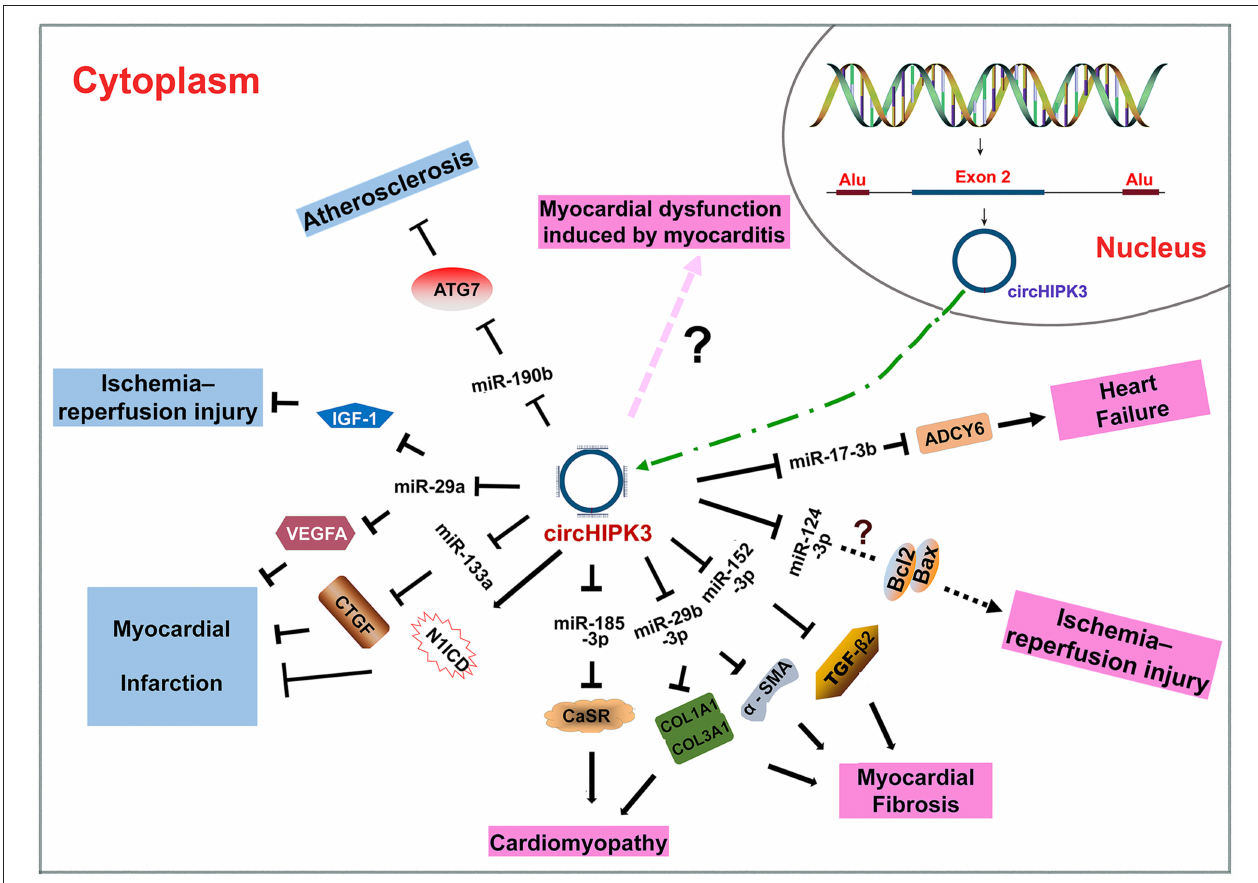
FIGURE 2 | Biogenesis of circHIPK3 and the roles of circHIPK3 in CVD. CircHIPK3 is an ecRNA produced with the help of Alu repeats. CircHIPK3 is transported into the cytoplasm and functions as an miRNA sponge. CircHIPK3 can suppress the pathogenesis of atherosclerosis, myocardial injury, and myocardial infarction. CircHIPK3 can also promote the pathogenesis of cardiomyopathy, myocardial fibrosis, myocardial injury, myocardial dysfunction, and heart